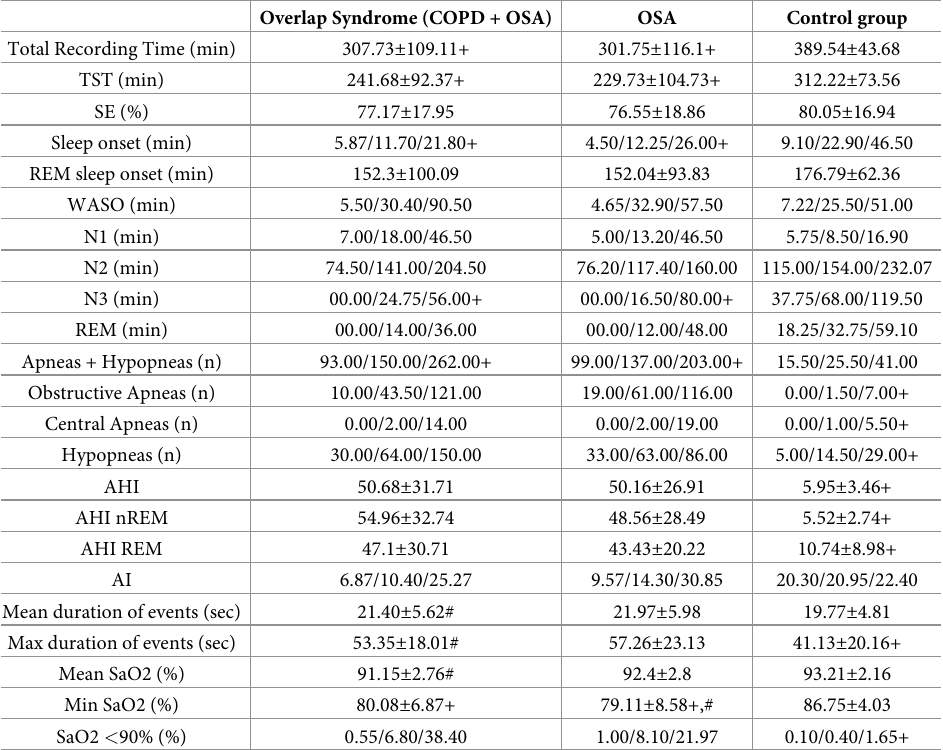
Table 2. Sleep characteristics of the three groups (mean±SD or 1 st quartile/median/3 rd quartile).